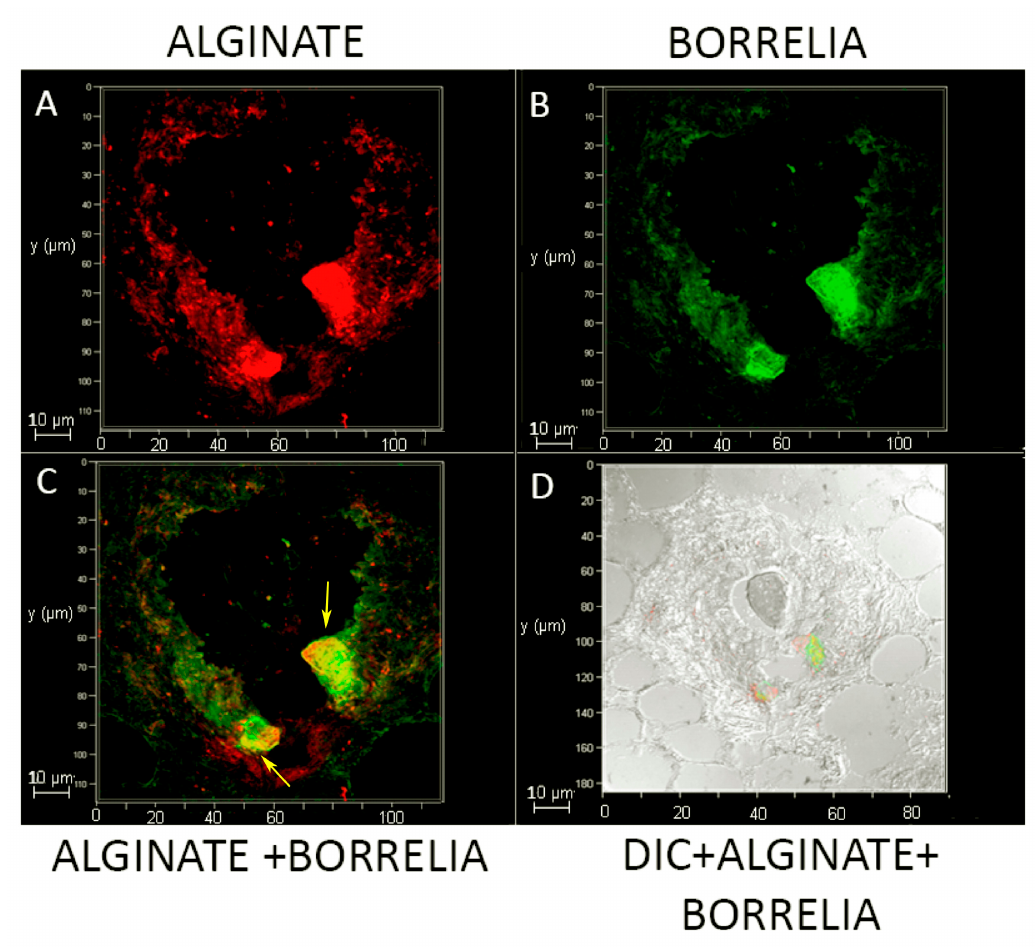
Figure 4. Fluorescent microscopy analysis of biofilm forms of B. burgdorferi in infected murine skin biopsies inoculated with 1 × 10 7 spirochetes and cultured in BSK-H 6% + RS for 14 days. The samples were immunostained for alginate (panel ( A )) and B. burgdorferi (panel ( B )) antigens. Panel ( C ) shows a merged image with alginate and B. burgdorferi staining (yellow arrows demonstrating overlapping staining). Panel ( D ) shows a merged image with differential interference microscopy (DIC) and alginate and B. burgdorferi staining; 630× magnification. Scale bars show 10 μ m.